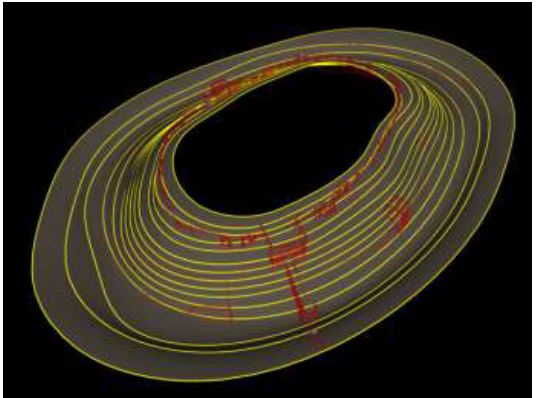
Figure 10. A site example for Aleppo on the planned website